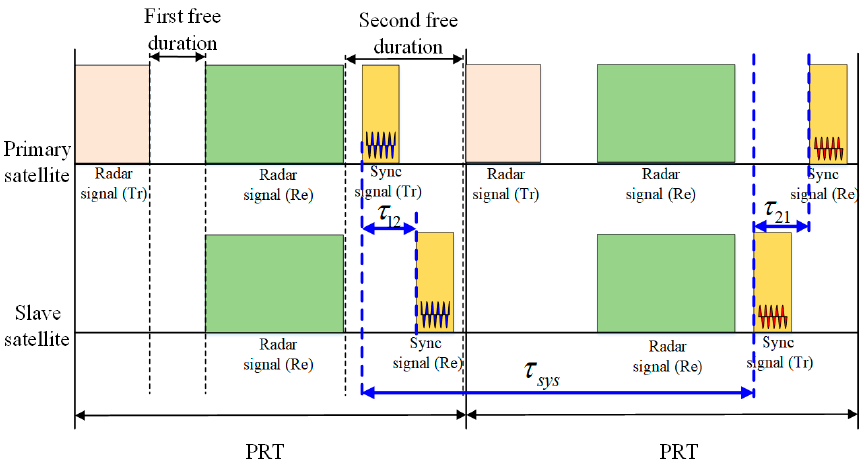
Figure 2. Timing diagrams of synchronization pulse exchange.